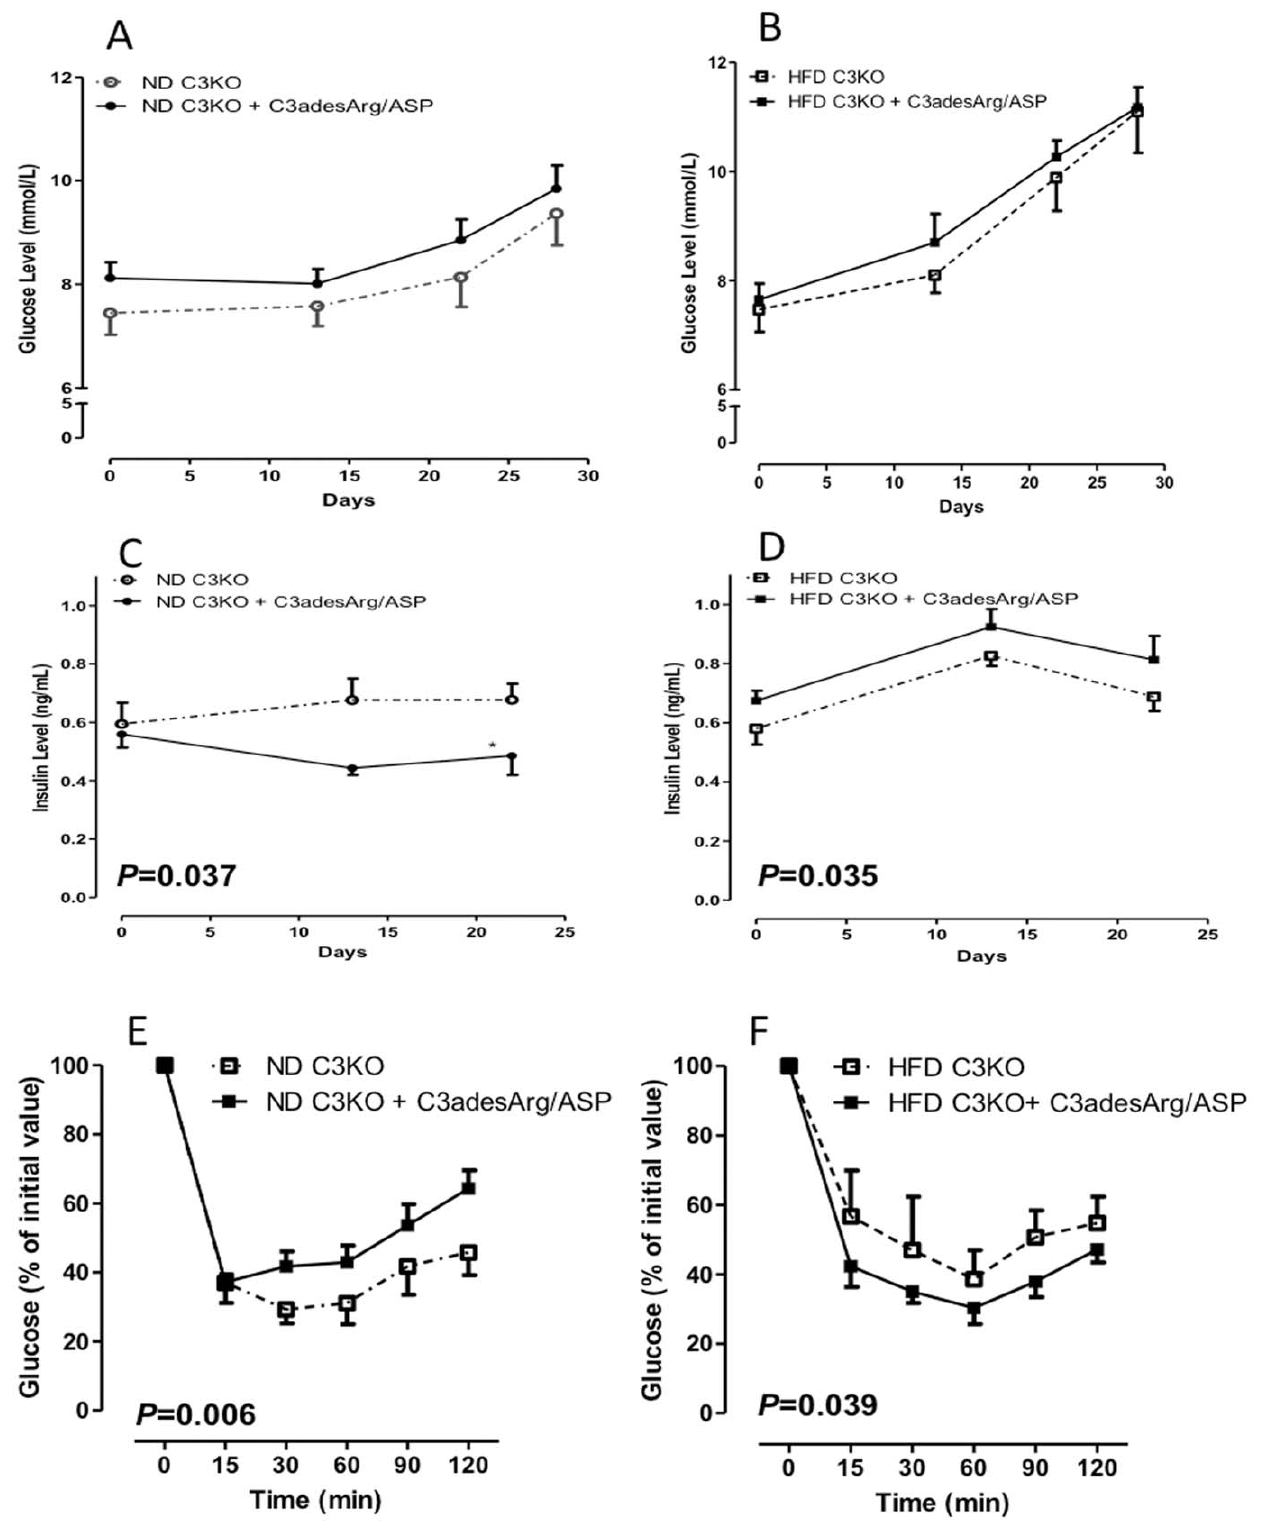
Figure 2. Chronic 4-week ASP treatment altered C3KO peripheral insulin sensitivity. Results are presented for glucose and insulin levels over the time course of treatment for ND ( A, C ) and HFD ( B, D ). E and F) Insulin tolerance tests in C3KO mice 6 ASP on ND (E) and HFD (F) Results are presented as average 6 SEM for n=8 2 9 where values for 2way ANOVA are provided in graphs.